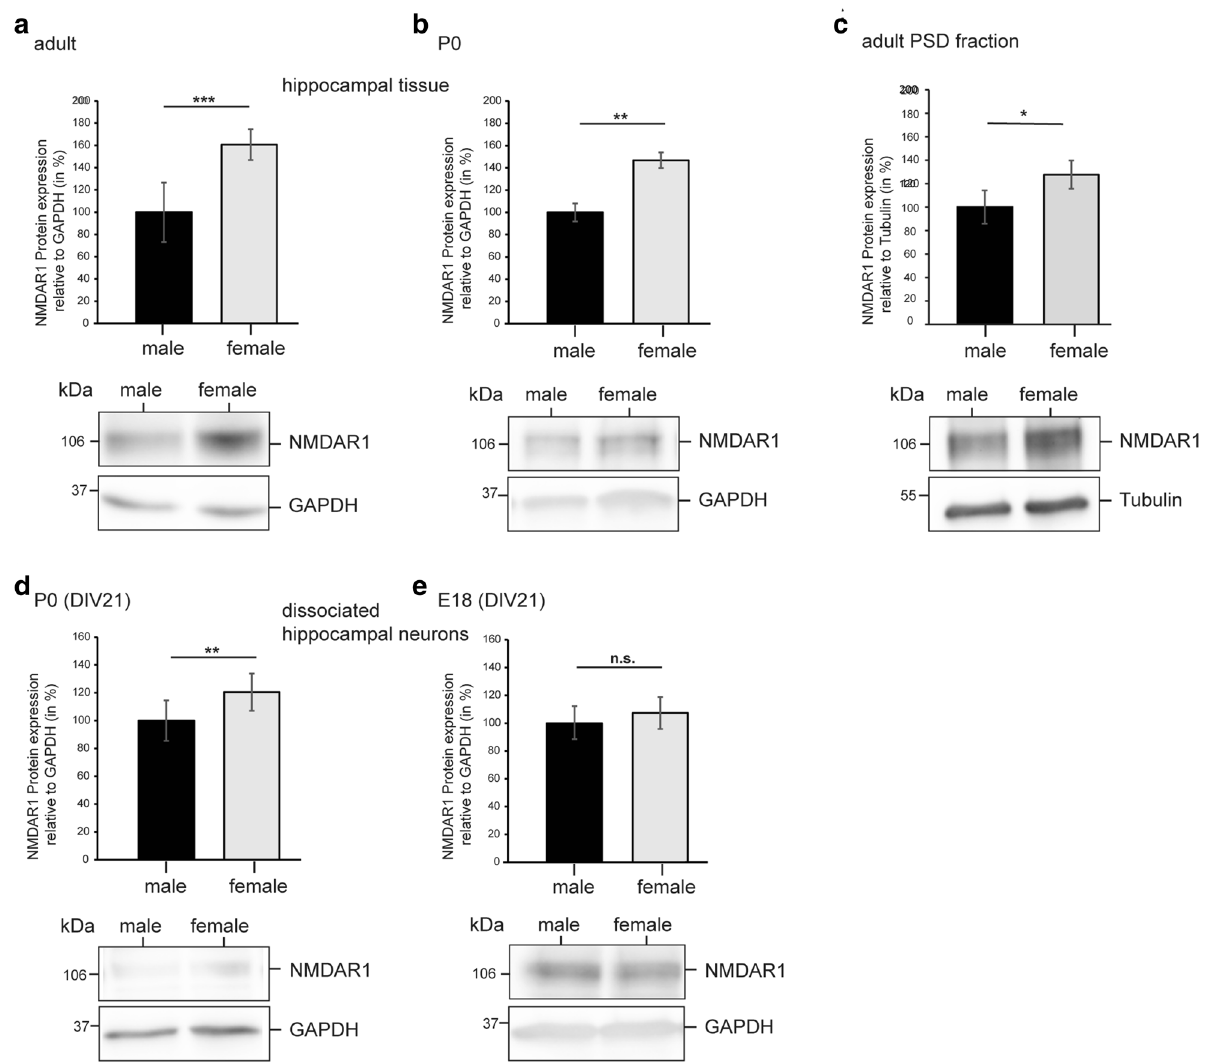
Figure 3. Female hippocampal neurons display more NMDAR1 receptors than male neurons. Western blot analyses of endogenous NMDAR1 levels in hippocampal tissue and cultured hippocampal neurons. All immunoblots were probed with either anti-NMDAR1 antibody (~ 106 kDa) or anti-GAPDH monoclonal antibody (loading control; ~ 37 kDa). Protein levels were quantified and normalized according to the levels of GAPDH protein. Abbreviations: P0 (postnatal day 0), E18 (embryonic day 18), DIV (days in vitro). Please note that different exposure times are shown. Data are normalized to male levels. ( a ) Quantitative analysis of hippocampal tissue of adult male and female mice revealed stronger expression of NMDAR1 in female mice (***p < 0.001; Mann–Whitney U test; male: n = 6 animals with n = 10 blots, female: n = 8 animals with n = 10 blots). ( b ) Quantitative analysis of hippocampal tissue of P0 male and female mice revealed stronger expression of NMDAR1 in female mice (**p = 0.007; Mann–Whitney U test; male: n = 10 animals with n = 8 blots, female: n = 8 animals with n = 8 blots). ( c ) The adult female hippocampal PSD fraction displays more NMDAR1 receptors than the male hippocampal PSD fraction. Western blot analyses of endogenous NMDAR1 levels in hippocampal PSD fraction. All immunoblots were probed either with anti-NMDAR1 antibody (~ 106 kDa) or anti-Tubulin monoclonal antibody (loading control; ~ 55 kDa). Protein levels were quantified and normalized according to the levels of Tubulin protein (*p = 0.05; Student’s t-test; male: n = 14 animals used for PSD preparation with n = 6 blots, female: n = 15 animals used for preparation with n = 6 blots). ( d ) Quantitative analysis of male and female hippocampal neurons at DIV21 (preparation day P0) revealed stronger expression of NMDAR1 in female cultures (**p = 0.006; Mann–Whitney U test; n = 4 independent cultures per sex with n = 12 blots). ( e ) No difference in NMDAR1 expression was observed after quantitative analysis of male and female hippocampal neurons after 21 days in culture (DIV21; preparation day E18; p = 0.492; Mann–Whitney U test; n = 4 independent cultures per sex with n = 11